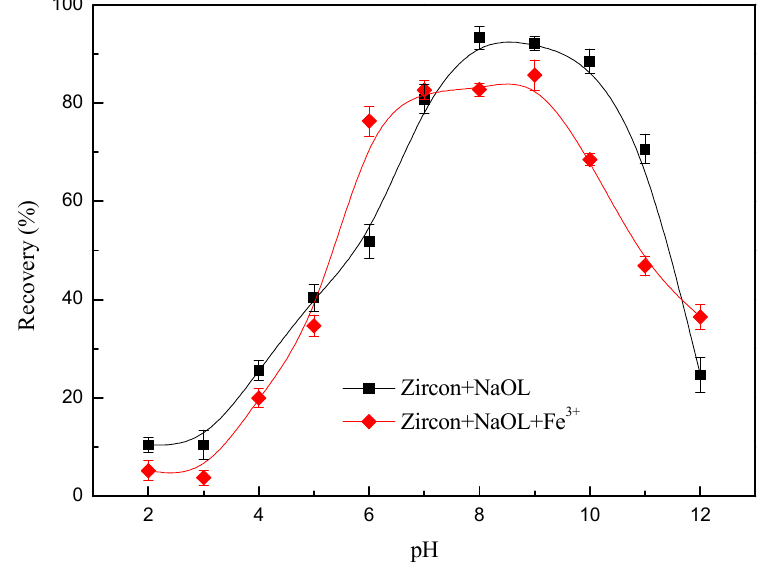
Figure 7. Flotation recovery of zircon as a function of pH with and without Fe 3+ (Fe 3+ : 8 × 10 − 5 mol/L; NaOL: 4 × 10 − 4 mol/L).